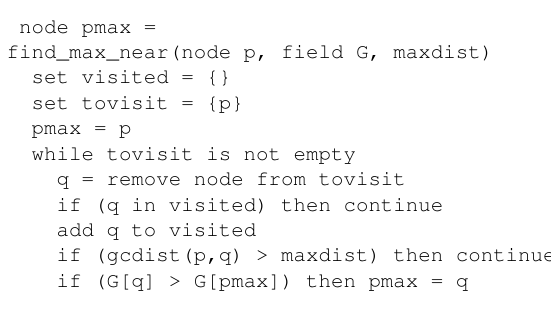
Algorithm 7 Determine all feature paths S , given array of